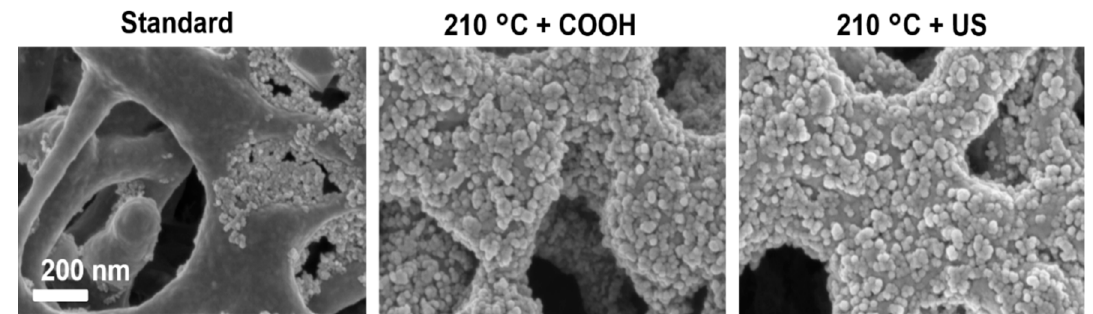
Figure 4. SEM image of a PES membrane with TiO 2 nanoparticles synthesized at 210 °C. Within the standard method no further modification of either membrane or nanoparticles was applied. The 210 °C + COOH method implemented COOH-groups via electron beam on the membrane before dip-coating. With the 210 °C + US method the nanoparticles in suspension were treated with ultrasound.